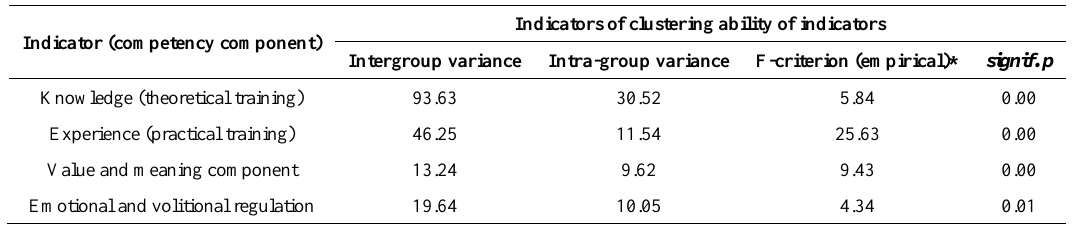
Table 3. Indicators used for clustering to determine the stages of students' professional competencies development and their